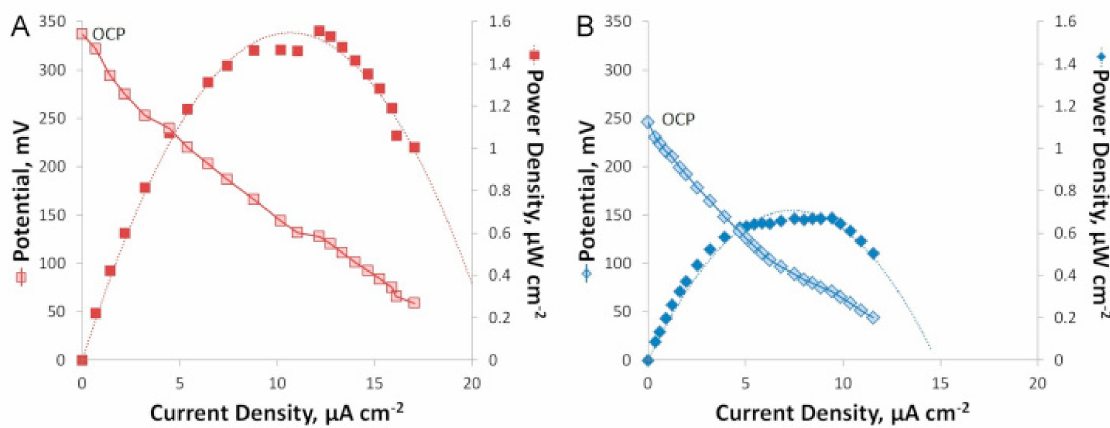
Figure 5. Potential and power density as function of the current density for the two investigated cells, indicated in Figure 4. ( A ) Open circuit potential and power density for cell with two parallel channels, ( B ) Open circuit potential and power density for cell with one single channel